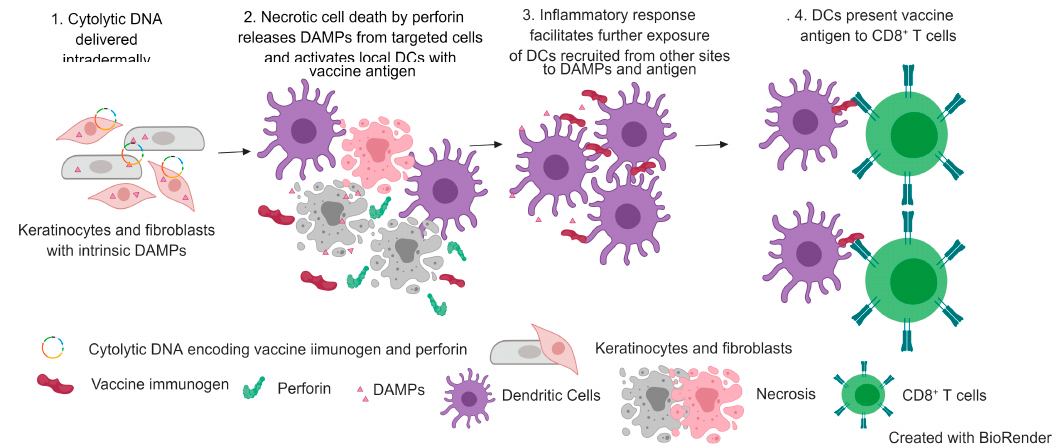
Figure 2. Mechanism of rDNA-PRF immunogenicity.